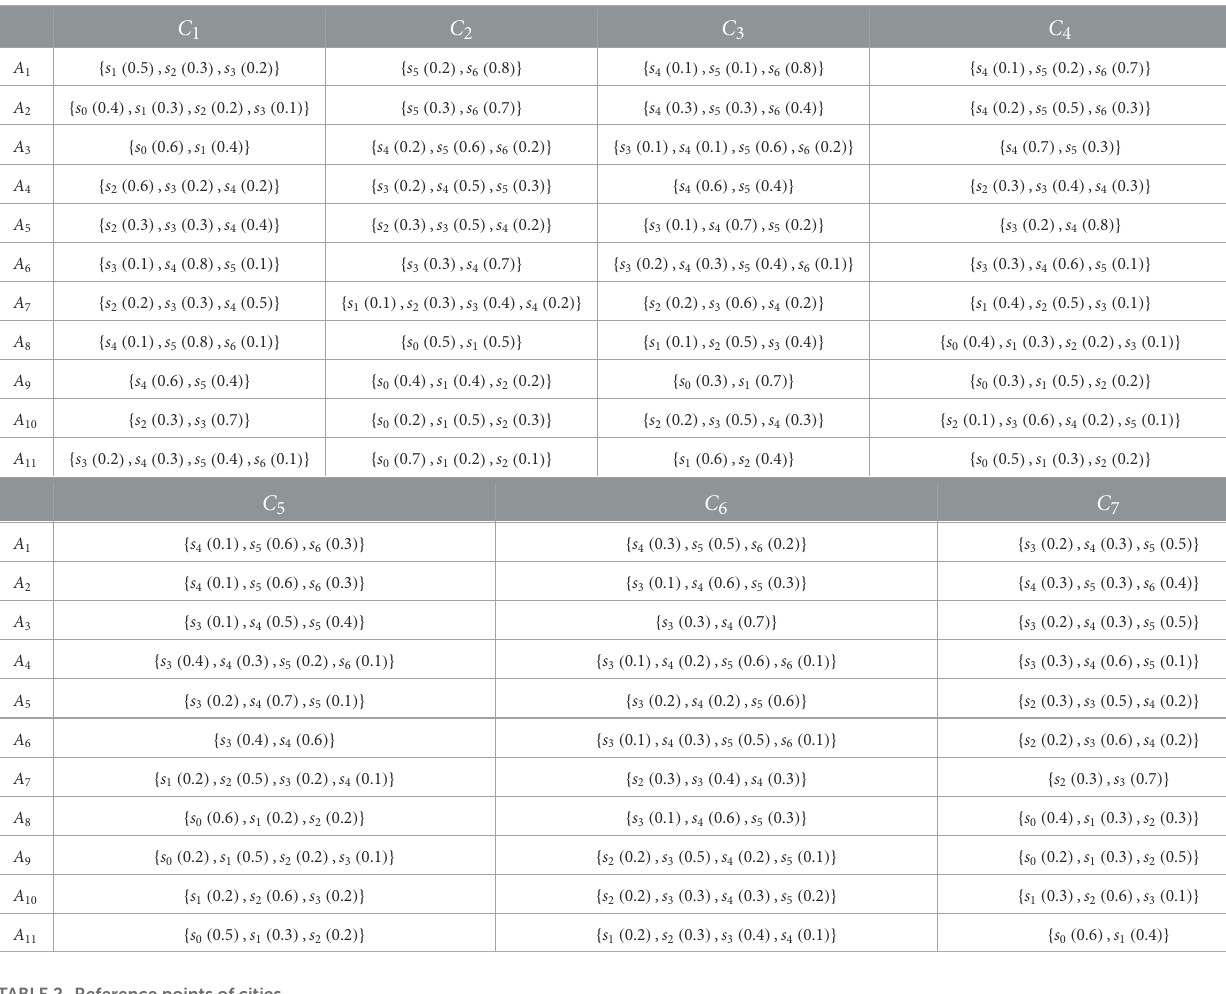
TABLE 1 Probabilistic linguistic evaluation matrix. C 1 C 2 C 3